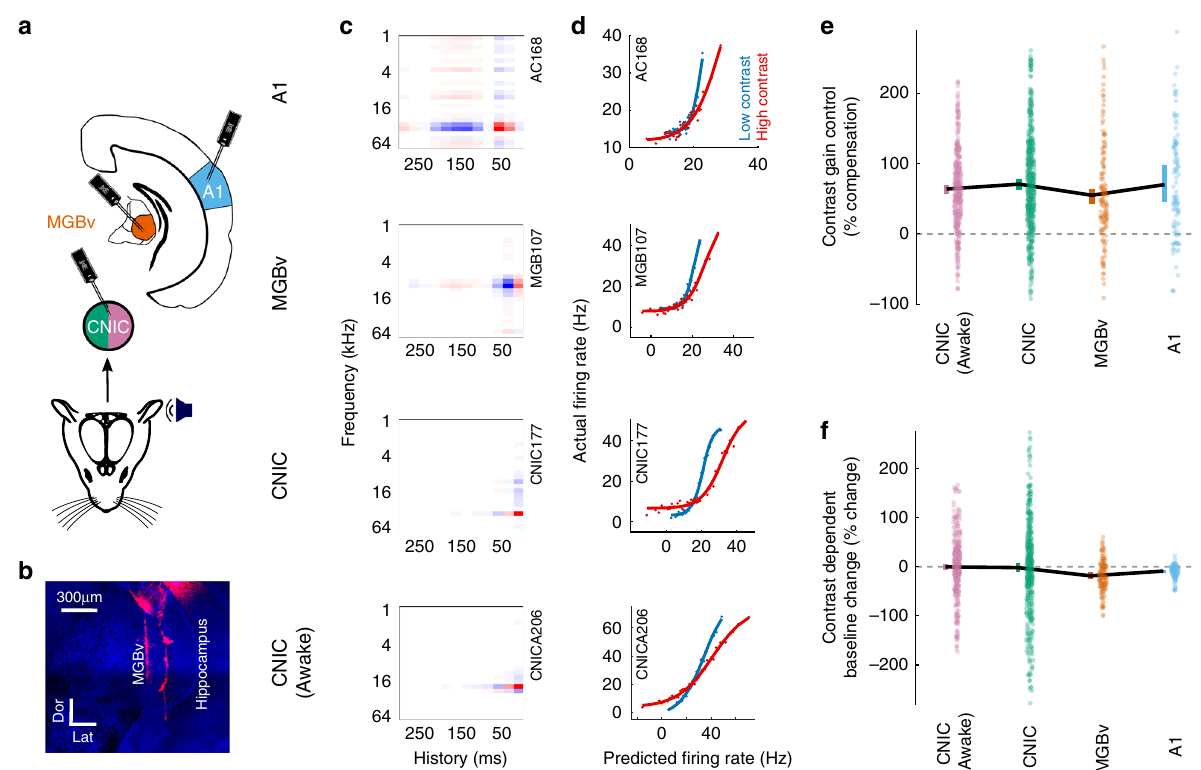
Fig. 3 Contrast adaptation in the lemniscal auditory pathway. a Schematic illustrating recordings in A1 and MGBv (under anesthesia) and in the CNIC (in both anesthetized and awake mice). b Confocal image showing DiI-coated electrode tracks in the MGBv (Dor, dorsal, Lat, lateral; scale bar, 300 µ m). c Example STRFs from units recorded in each brain region (red: positive, white: 0, blue: negative). d Contrast-dependent output nonlinearities for these same four units. e Magnitude of contrast gain control in the auditory pathway, measured as % compensation where 100% would indicate a halving of the gain when the contrast is doubled. f Contrast-dependent changes in the baseline activity (y-offset of the output nonlinearity) in the auditory pathway. Colored error bars in e , f , 95% bootstrapped non-parametric con fi dence intervals (individual data points (excluding outliers) are displayed next to the corresponding error bars). Source data for e , f are provided as a Source Data fi